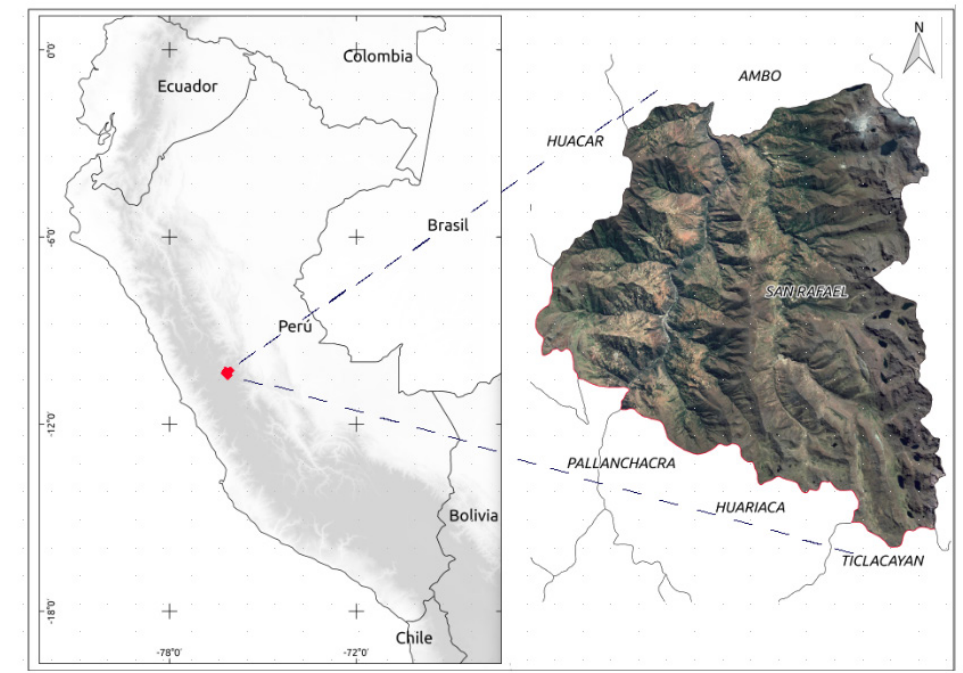
Figure 1: Location of the research